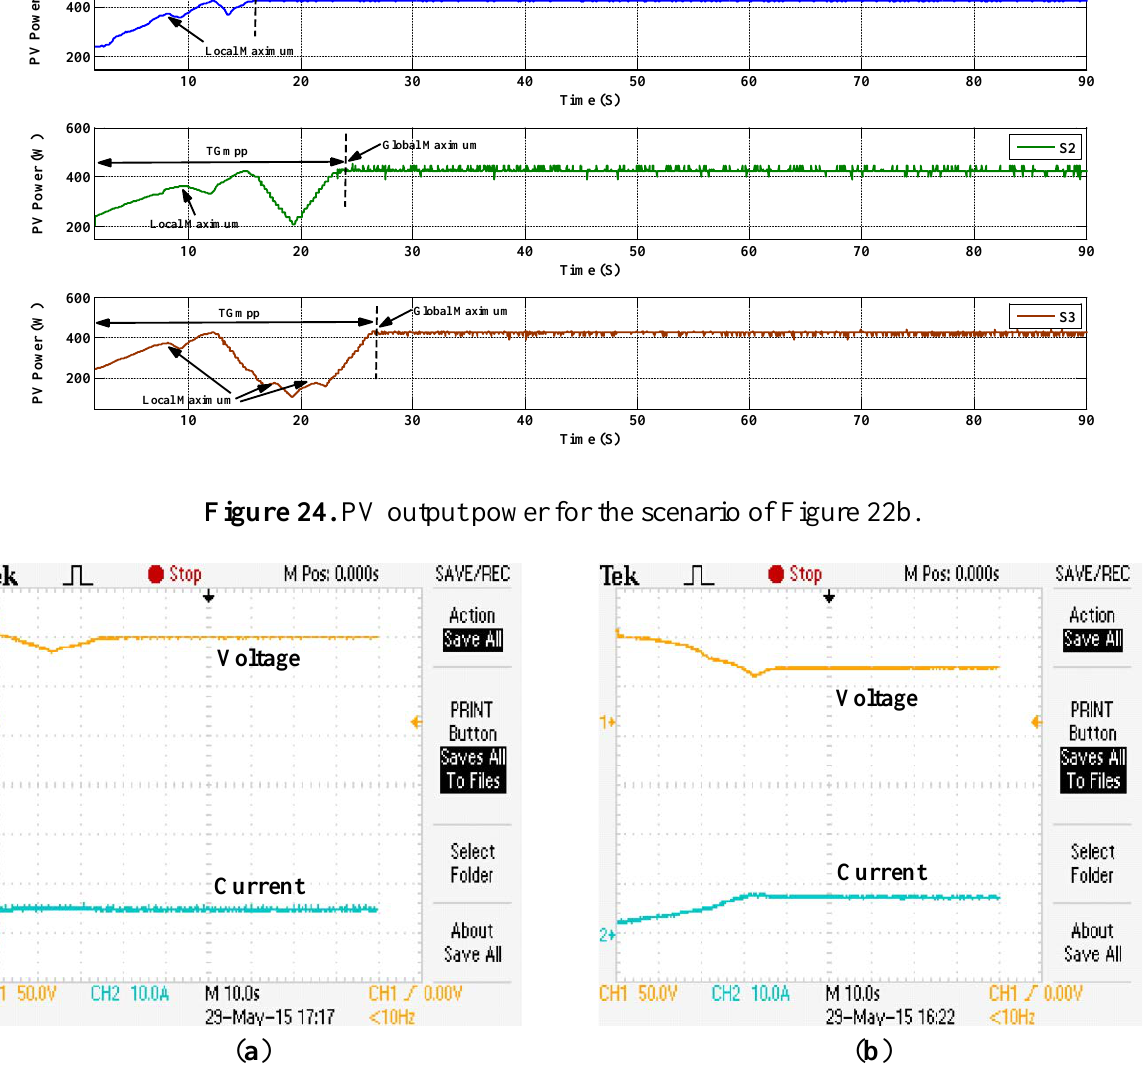
Figure 25. The performance of voltage and current for the scenarios of ( a ) Figure 22a and ( b ) Figure 22b by implementing the DSMPP